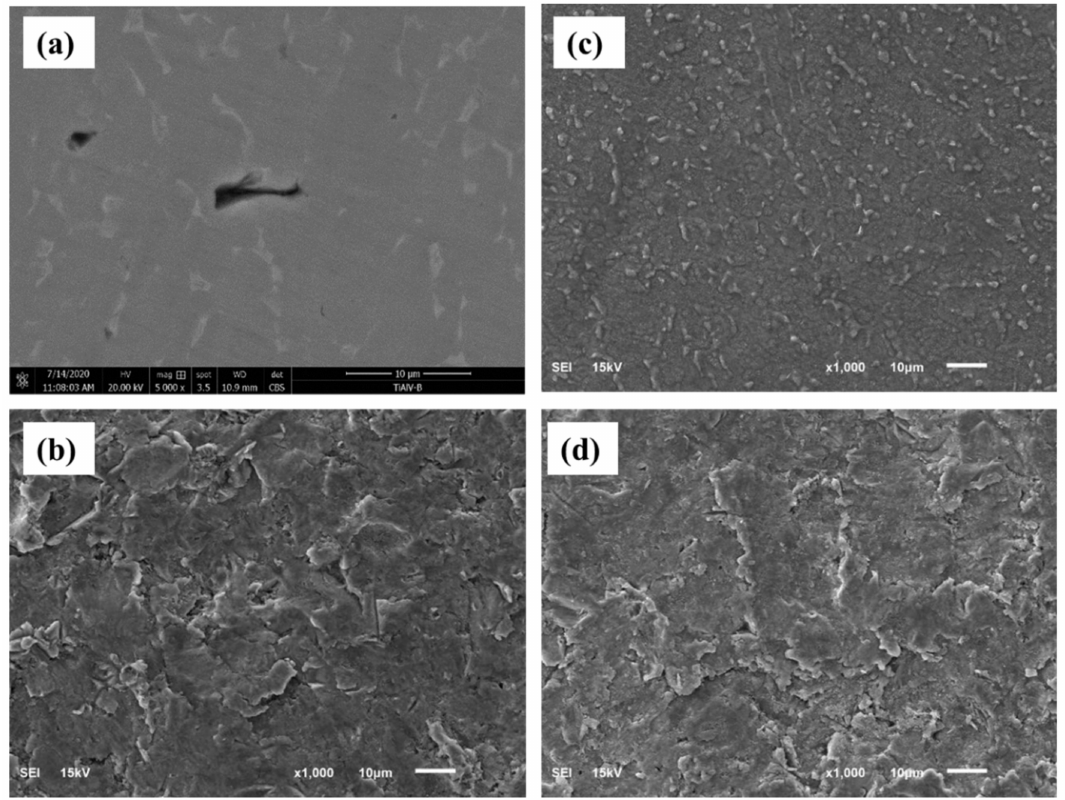
Figure 2. SEM micrograph of pretreated and treated Ti64 specimens ( a ) M, ( b ) SB, ( c ) MT, ( d )